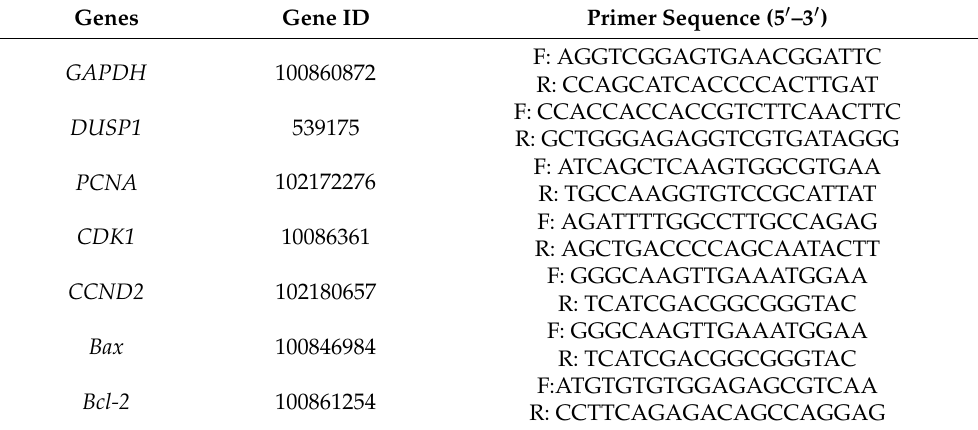
Table 1. Quantitative real-time PCR primer pairs.